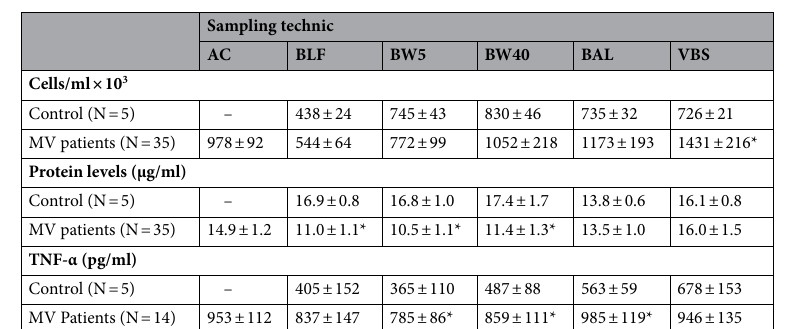
Table 1. Cell number, protein and TNF-α levels, in mucus dissolved samples obtained control subjects and mechanically ventilated (MV) patients. Sampling with tracheobronchial aspiration (AC), aspiration of bronchial lining fluid (BLF), bronchoalveolar lavage (BAL), bronchial washings (BW5, BW40) and visible bronchial secretions obtained via bronchoscopy (VBS). N refers to the number of subjects and data are presented as means ± SEM. * p < 0.05 for comparisons between control and patients (Mann–Whitney test).